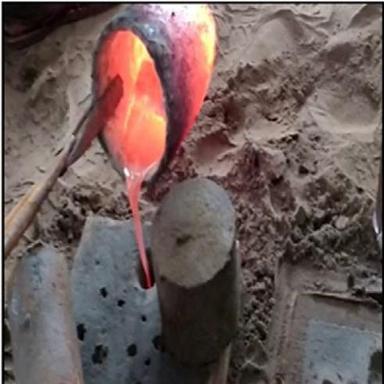
NMMC formation.